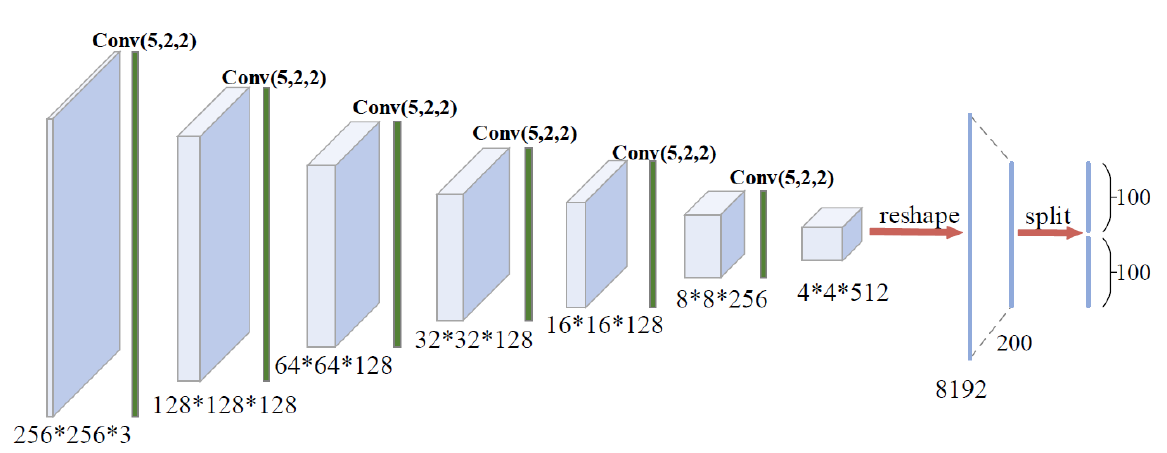
Figure 3. The architecture of the FGN.